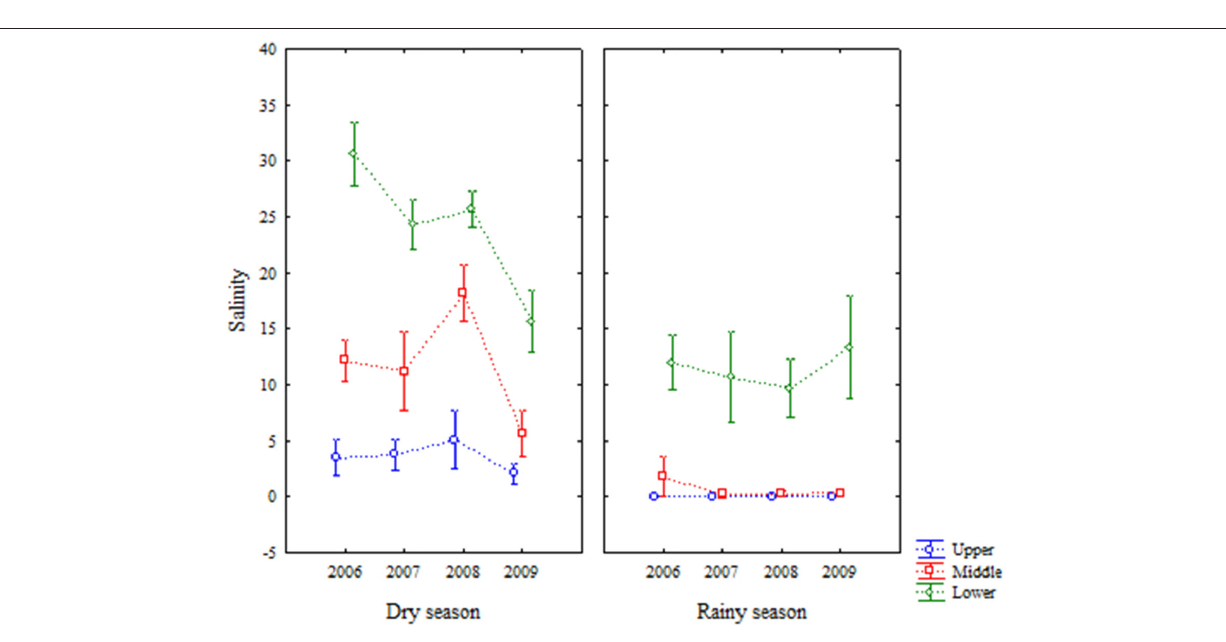
FIGURE 4 | Average ( ± standard deviation) of temporal (interannual and seasonal) variations of salinity at the Goiana River estuary from 2006 to